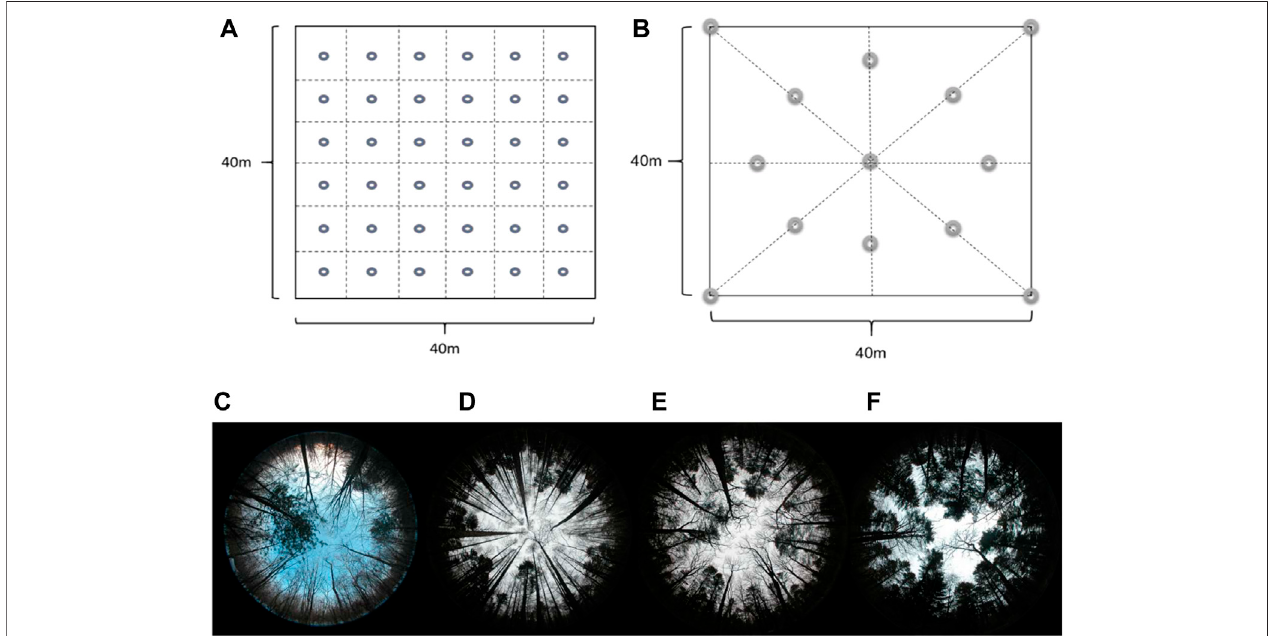
FIGURE 2 | Investigation strategy maps ofthe forest snow depth (A) , investigation location of canopy closure at the stand level (B) , and forest hemisphere images (bottom row, C, D, E, and F). The circles in (A) represent the location of snow rulers, and the circles in (B) represent image captures in the forest plot. Four forest hemisphereimages(bottomrow): (C) high-intensitycuttingmixedforest(HCF); (D) moderate-intensitycuttingmixedforest(MCF); (E) naturalmixedforest(NMF); (F) low- intensity cutting mixed forest (LCF).